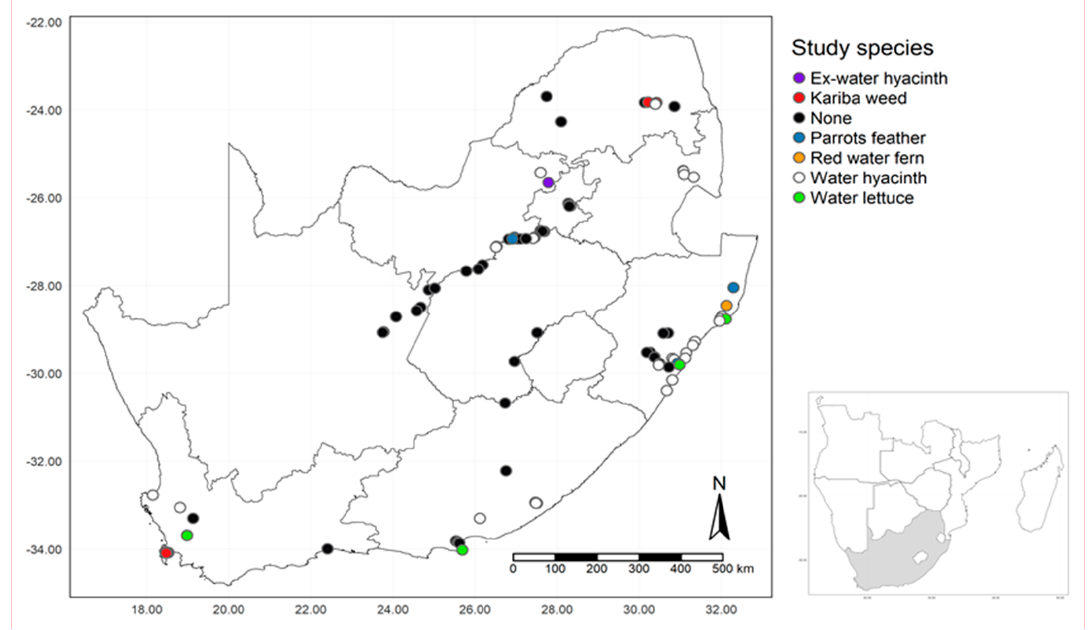
Figure 1. The field localities of five invasive aquatic alien plant (IAAP) species for 2013–2015 across 98 sites within South Africa including sites with detected aquatic vegetation but none of the five IAAPs (Unpublished data, [43]). The period, 2013–2015 corresponds to a temporal window of concurrent availability of both the Landsat-8 satellite data and the field IAAP locality data. Note, the strong imbalance between the seven classes in favor of water hyacinth and against the other IAAP species. As a result, the water hyacinth localities were used as the target (positive) class whilst the remaining categories were combined to form the non-target (negative) class.